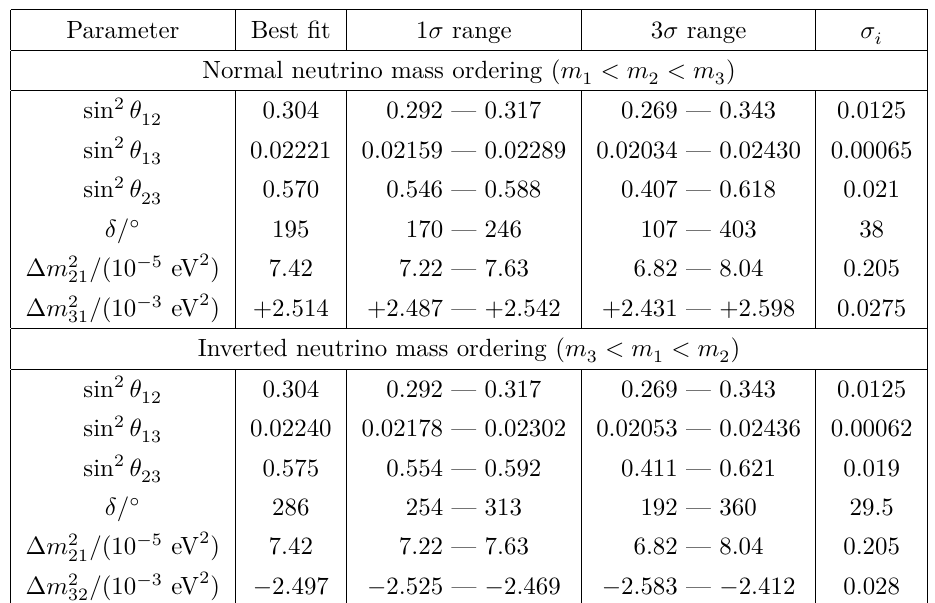
being the i , θ , θ } , two neutrino mass- 12 13 23